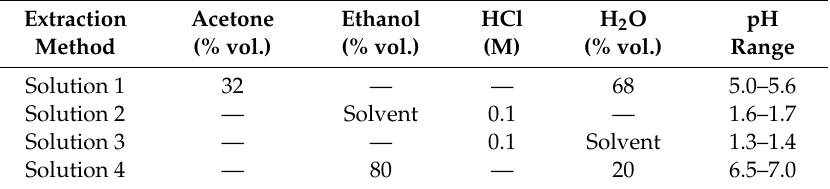
Table 1. Solutions used for extracting the dye from vegetable raw materials.